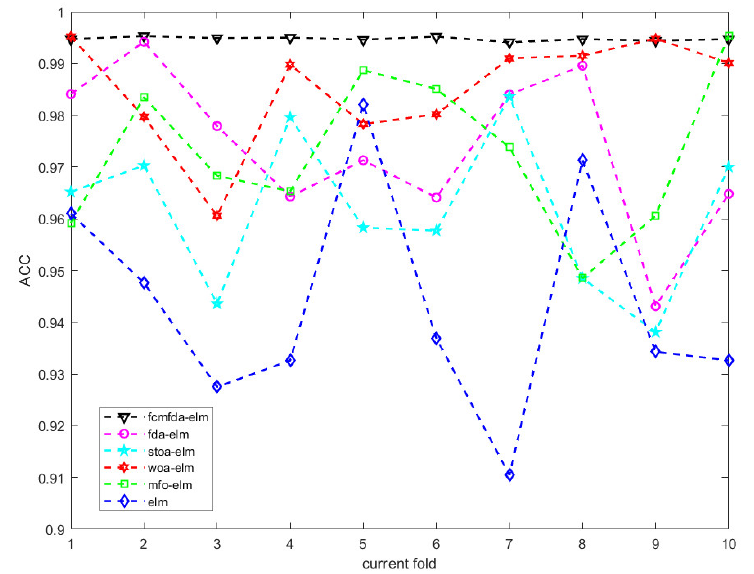
Figure 9. Four indicators and their standard deviation of all methods (Fish4Knowledge).